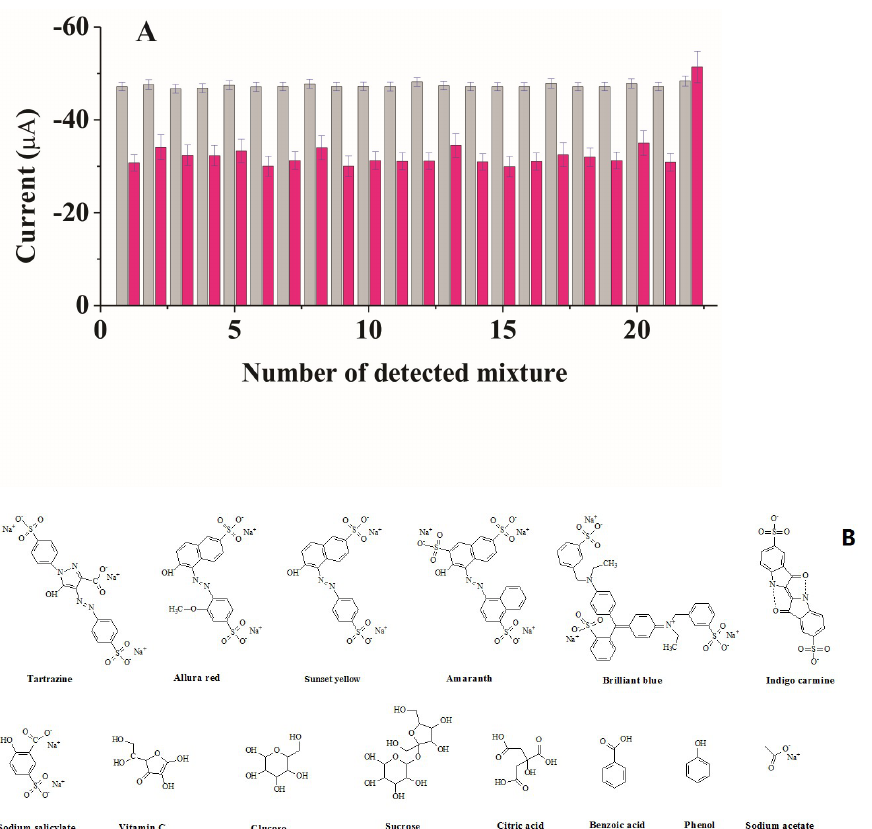
Figure 5. ( A ) Influence of coexisting substances on the electrochemical response of GCE/GO–PtCo@MIPDA (grey) and GCE/GO–PtCo (pink) to TZ. Solution composition: (1) 3.5 µ M TZ in 0.2 M acetate buffer solution (pH = 6.0); (2 to 21) with 0.1 mM of (2) Allura Red, (3) sunset yellow, (4) amaranth, (5) brilliant blue, (6) indigo carmine, (7) sodium salicylate, (8) vitamin C, (9) glucose, (10) sucrose, (11) citric acid, (12) benzoic acid, (13) phenol, (14) sodium acetate, (15) Ca 2+ , (16) K + , (17) Fe 3+ , (18) Zn 2+ , (19) SO 4 2 − , (20) NO 2 − , (21) Cl − , and (22) a mixture of (1) and the other 20 kinds of interferents (50 µ M each). ( B ) Molecular structures of some of the